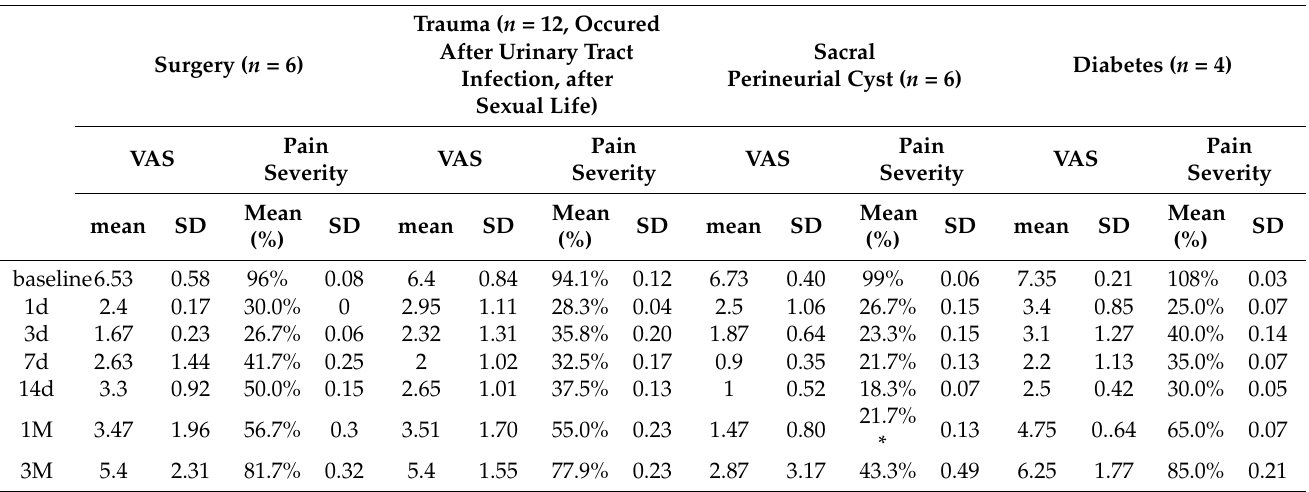
Table 5. Changes in VAS and pain severity from baseline in the secondary pudendal neuralgia group. * One-way ANOVA test for 4 types of secondary PN comparison, p < 0.05. PRF = pulsed radiofrequency, VAS = Visual Analog Scale, D = day, M =